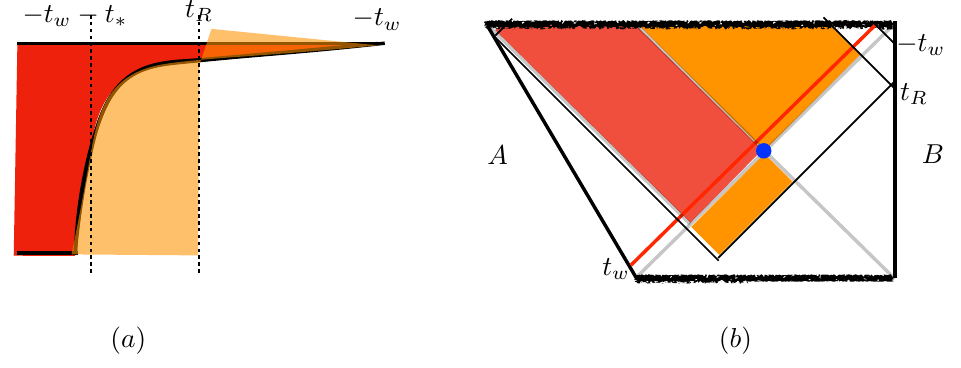
Figure 8 . (a) Quantum circuit at − t w − t ∗ < t R < − t w . As Bob decreases the right time, he will create a fold on top of the sick gates. (b) WDW patch at − t w − t ∗ < t R < − t w